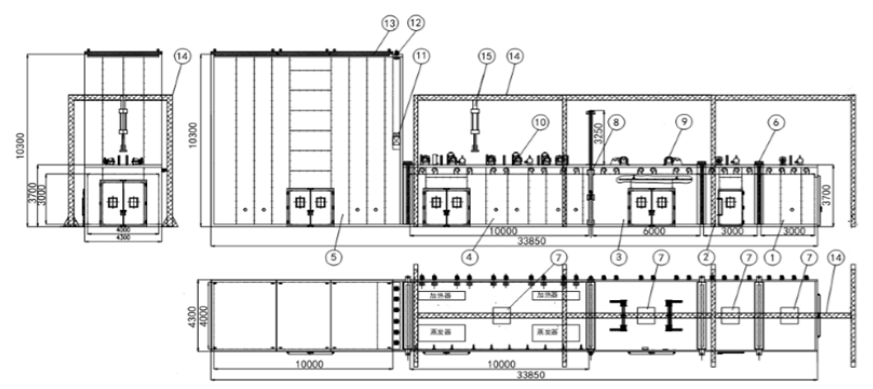
Figure 2. The large environment box with variable space.